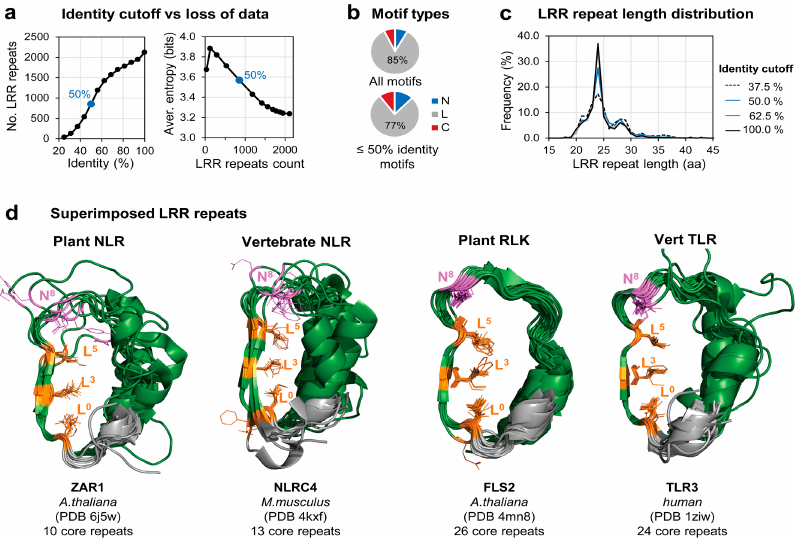
Figure A1. Available LRR domains structural data. ( a ) Identity cut-off versus loss of data: plots of the loss of samples (left) and increase in entropy (right) at different identity thresholds. Displayed is the Shannon entropy averaged over the 16 amino acid extended motif. ( b ) Composition of LRR motif types: N-entry (N), core (L), and C-exit (C) LRR motifs in the initial set (ID90) and in the 50% identity trimmed dataset (ID50). ( c ) LRR repeat length distribution at different identity thresholds. C-exit motifs were not used. ( d ) Structural superposition of the LRR repeats from a plant NLR, vertebrate NLR, plant RLK and vertebrate TLR structures [22,77–79] (from left to right). Hydrophobic positions of the minimal ‘L 0 xxL 3 xL 5 ’ motif are shown in orange and position N 8 in purple.